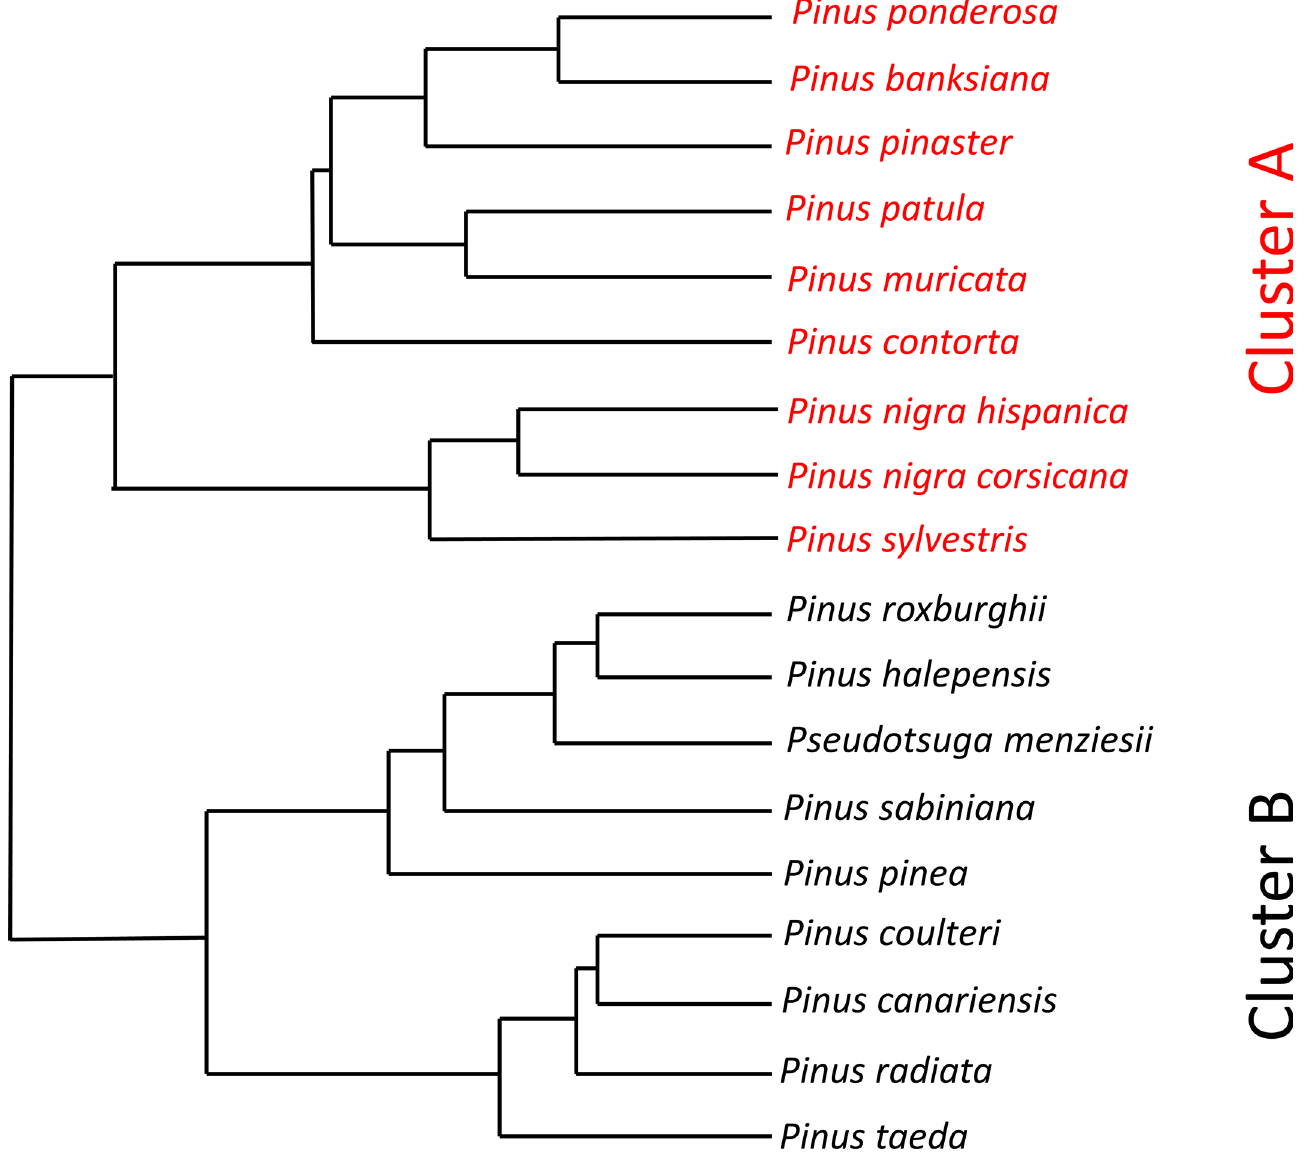
Fig 1. Defensive phenogram showing similarity among 18 conifer species of four constitutive defensive traits, four defensive traits induced by the jasmonic acid signaling pathway and four defensive traits induced by the salicylic acid pathway. Closely clustered species show similar integrated defensive phenotypes and form two defense syndromes (Cluster A in red font and Cluster B in black